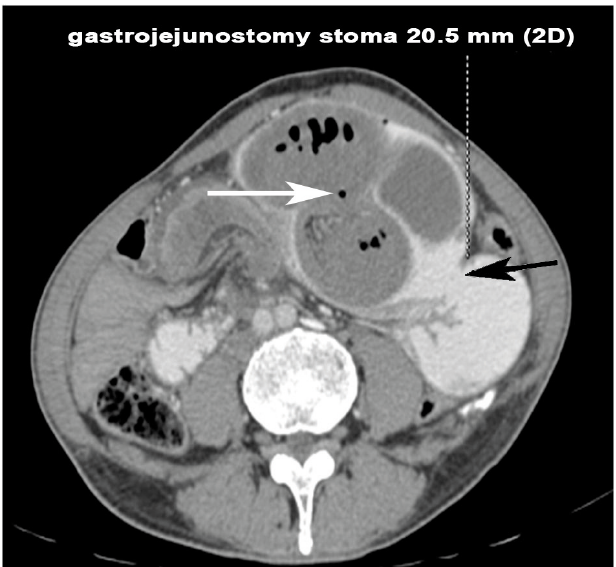
Fig. 1. Axial CECT of the patient showing retrograde intussusception of the jejunal loops within the stomach, the black arrow pointing towards the gastrojejunostomy stoma and its size shown by the broken line. A small intramural air density was noted in the intussuscepted bowel (white arrow). Efferent loop of the gastrojejunostomy site involved is diagnostic of type II variety.